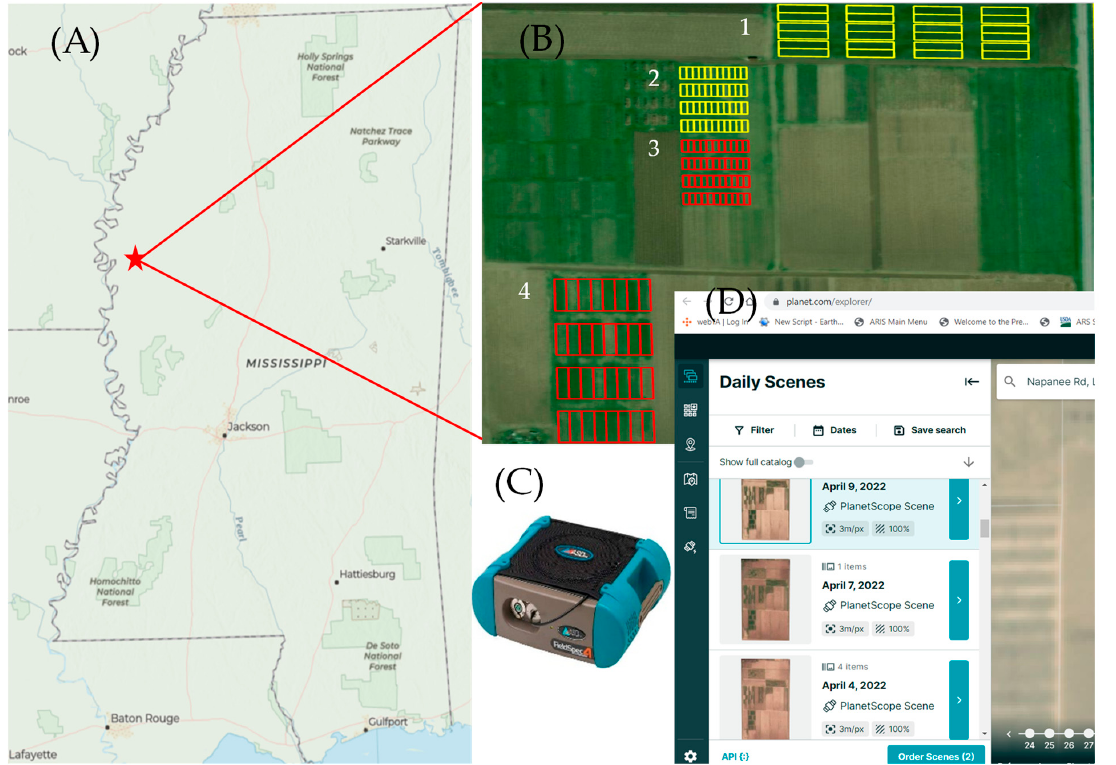
Figure 1. Study site and data products used. ( A ) Mississippi state map with the Crop Production Systems Research Unit (CPSRU) location marked as star; ( B ) four study sites with cover crops (labeled 1–4) within CPSRU research farm (red with main crop corn and yellow with soybean, cover crop treatment detail is provided in Table 1); ( C ) hyperspectral spectroradiometer (Fieldspec4 Standard-Res) used to collect 350–2500 nm canopy reflectance; and ( D ) Planet imagery downloaded for the study site through Planet Explorer. Table 1. Description of study sites and sampling dates.